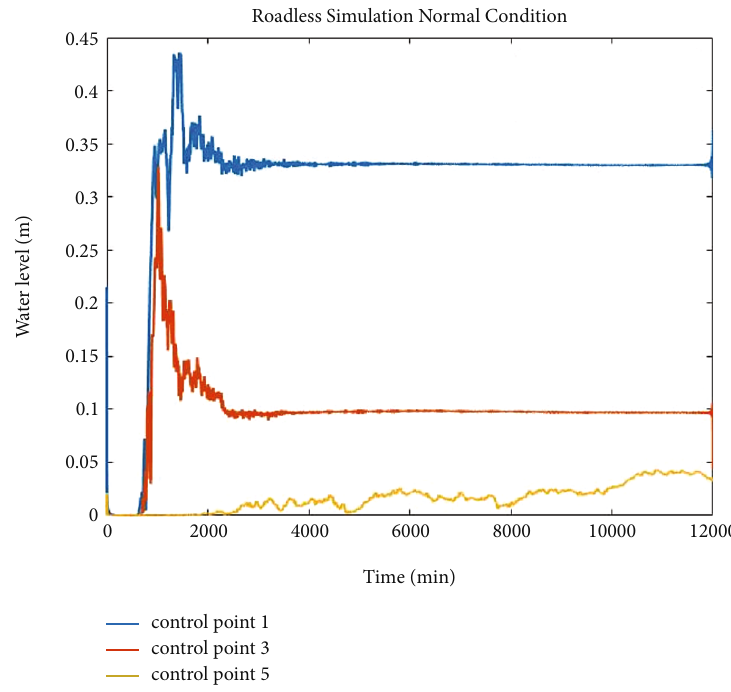
Figure 8: Fluctuation of the free-surface at the control point 1, 3, and 5 in roadless simulation normal